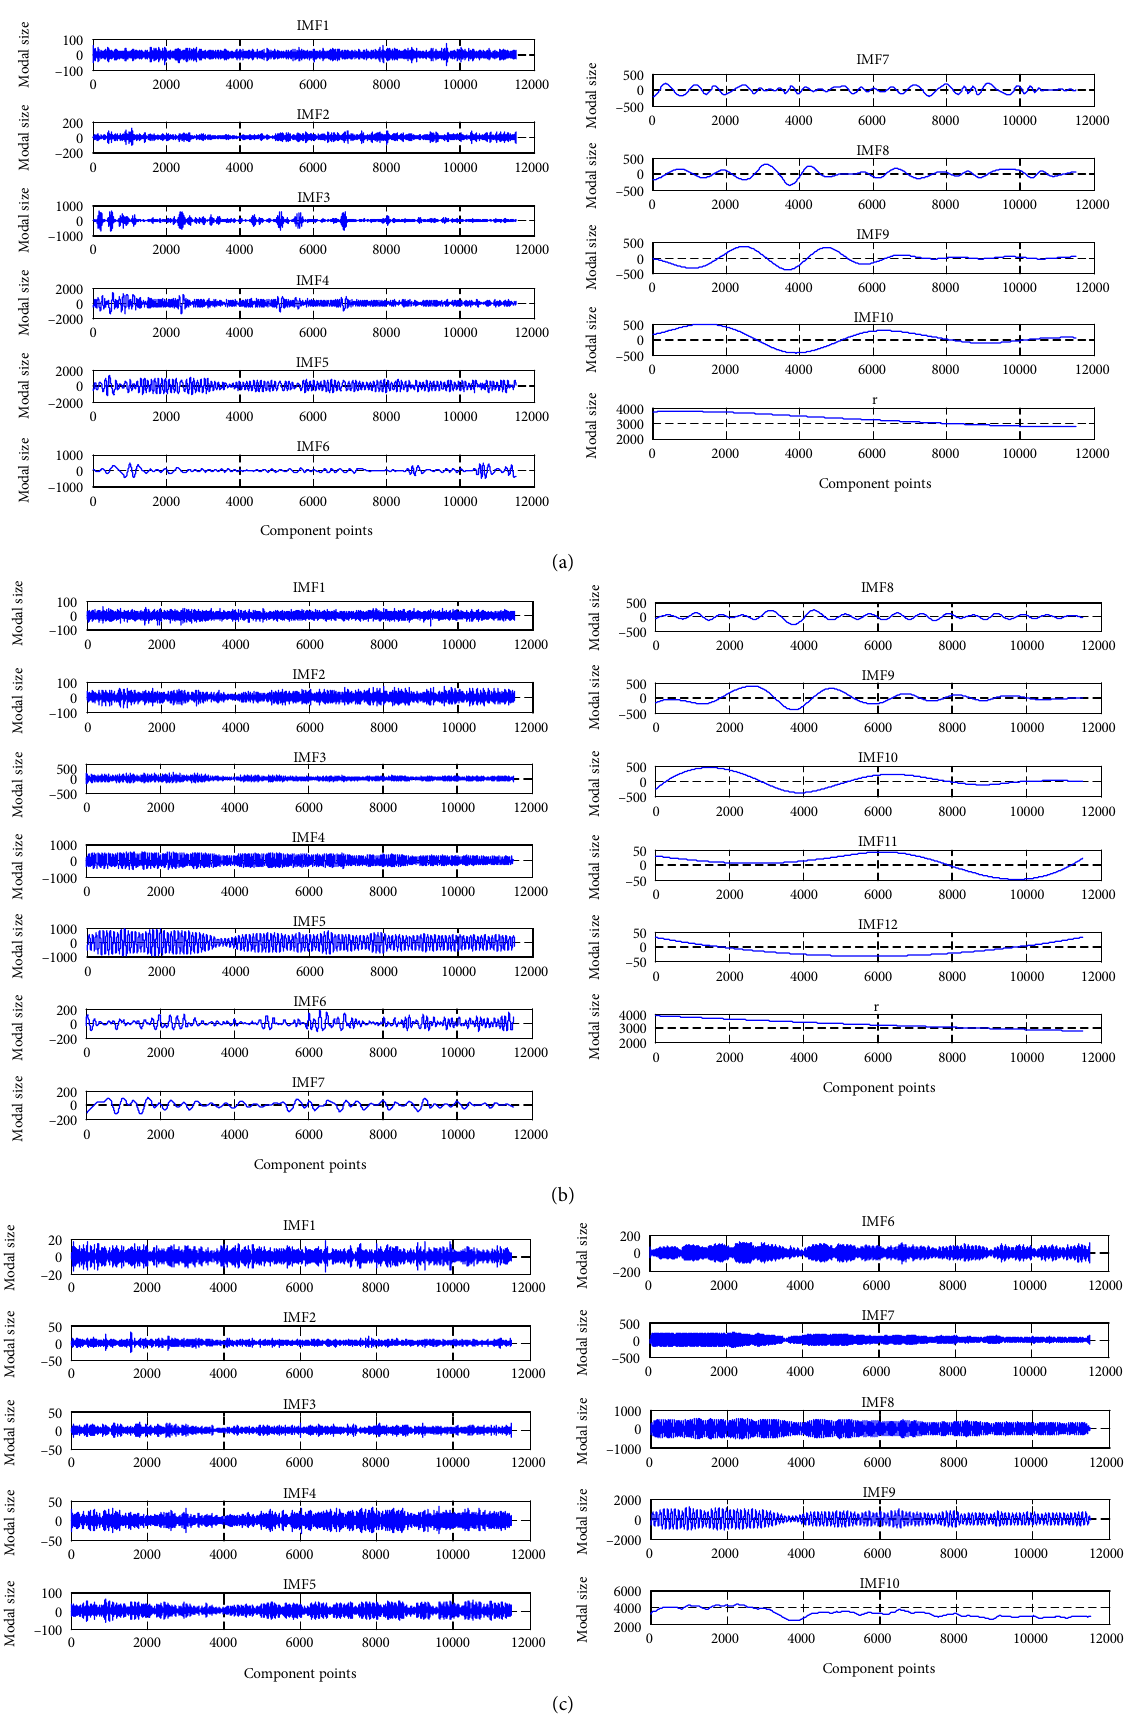
Figure 3: The exploded view of (a) EMD, (b) EEMD, and (c)